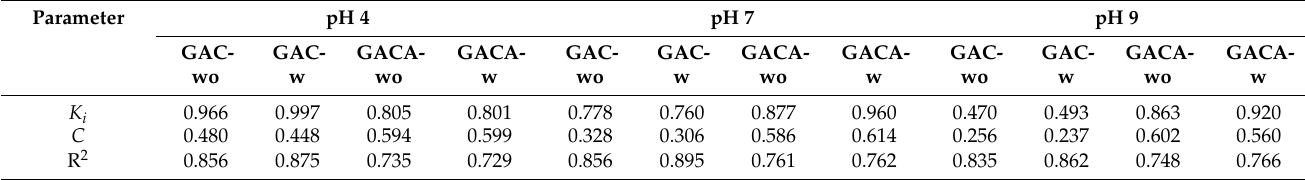
Figure 9. Intraparticle diffusion plot for GAC and GACA at initial of pH 4 ( a ), 7 ( b ), and 9 ( c ) (solid line: regression from 0 to 6 h). Table 5. Intraparticle diffusion parameters calculated from 0 h to 6